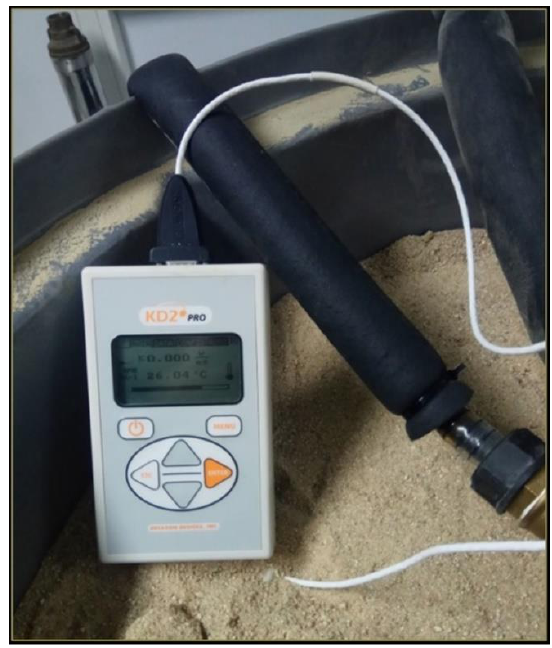
Figure 12. Measuring the ground thermal conductivity using KD2 Pro equipment and RK-1 sensor.